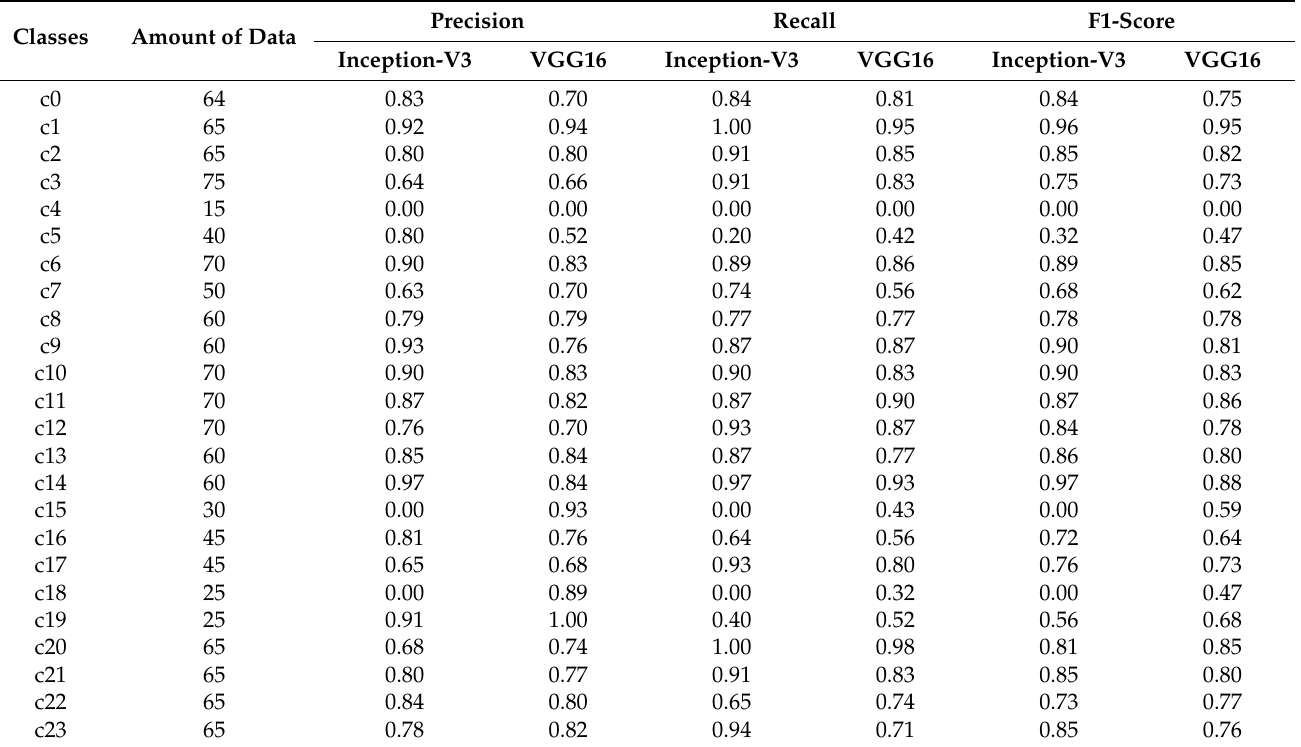
Table 1. The grayscale research dataset was used to create a classification report for the Inception-V3 model. Classes